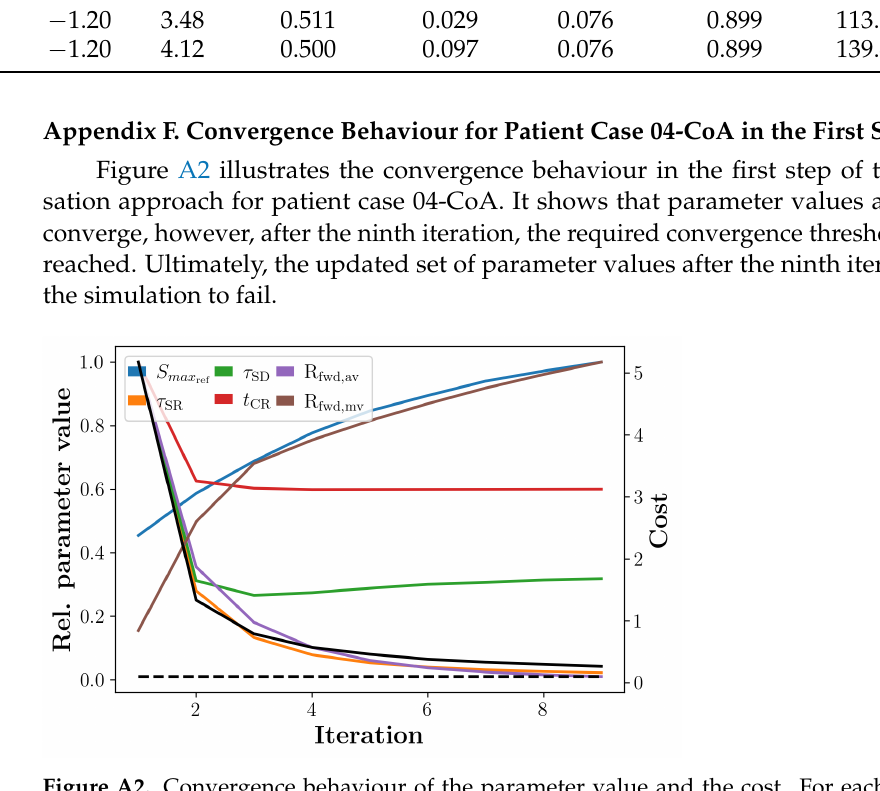
Figure A2. Convergence behaviour of the parameter value and the cost. For each iteration, the parameter values relative to their respective maxima (left y-axis; solid coloured lines) and the cost (right y-axis; solid black line) are plotted. In addition, the convergence threshold (0.1, dotted black line) is